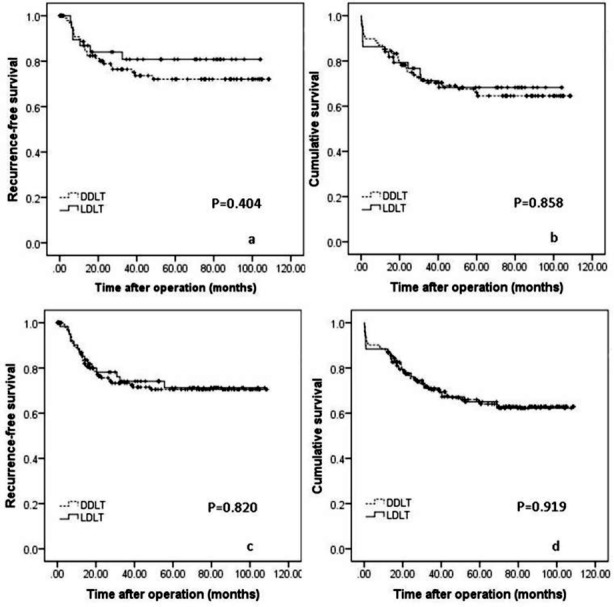
Comparison of the RFS (Fig.3a) and OS (Fig.3b) rates of LDLT and DDLT for patients with HCC within Hangzhou criteria. RFS (Fig.3c) and OS (Fig.3d) curves of LDLT versus DDLT for patients with HCC within Chengdu criteria.